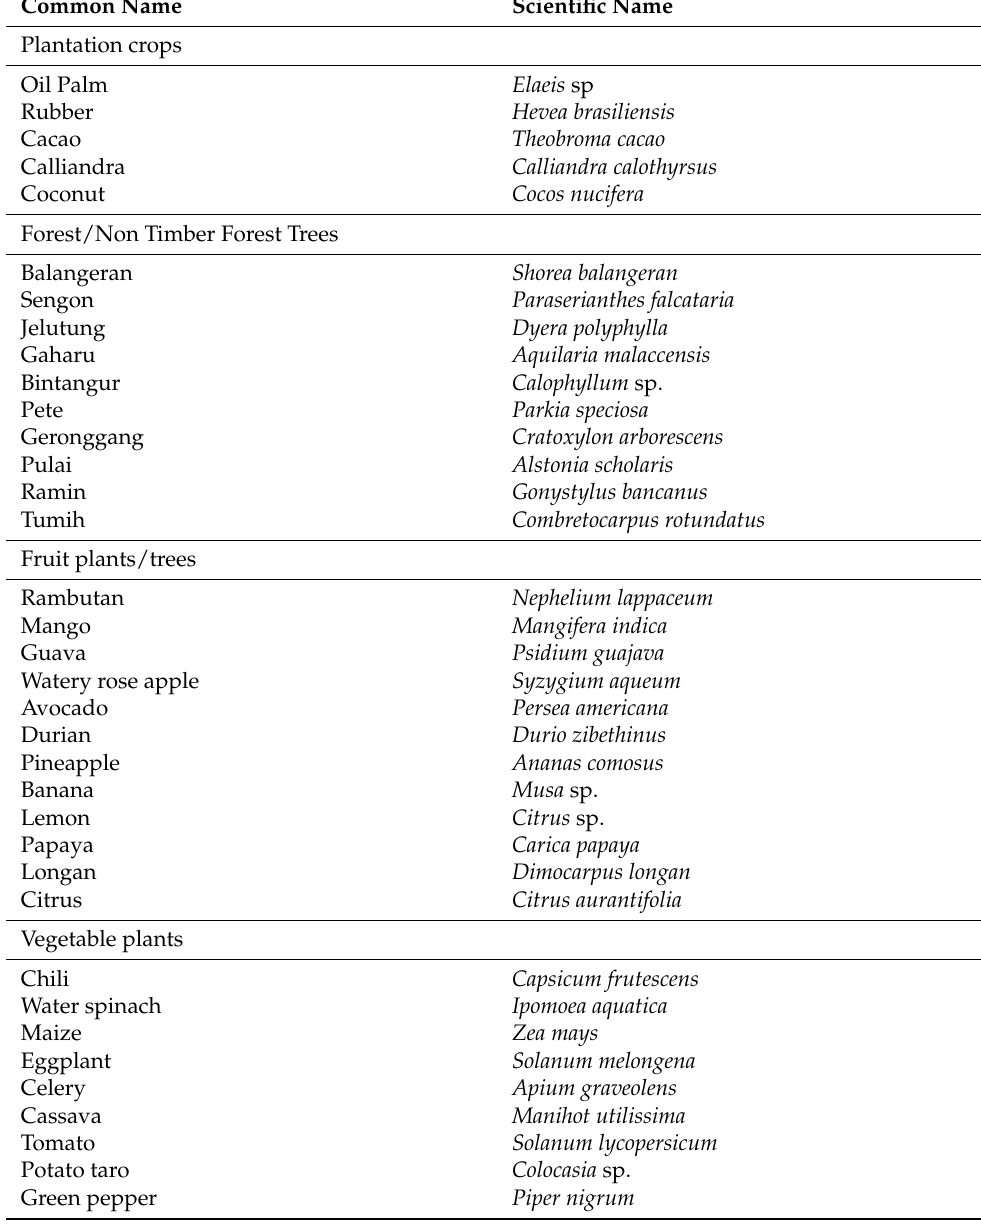
Table 1. Plant species cultivated in peatland home yards in Tumbang